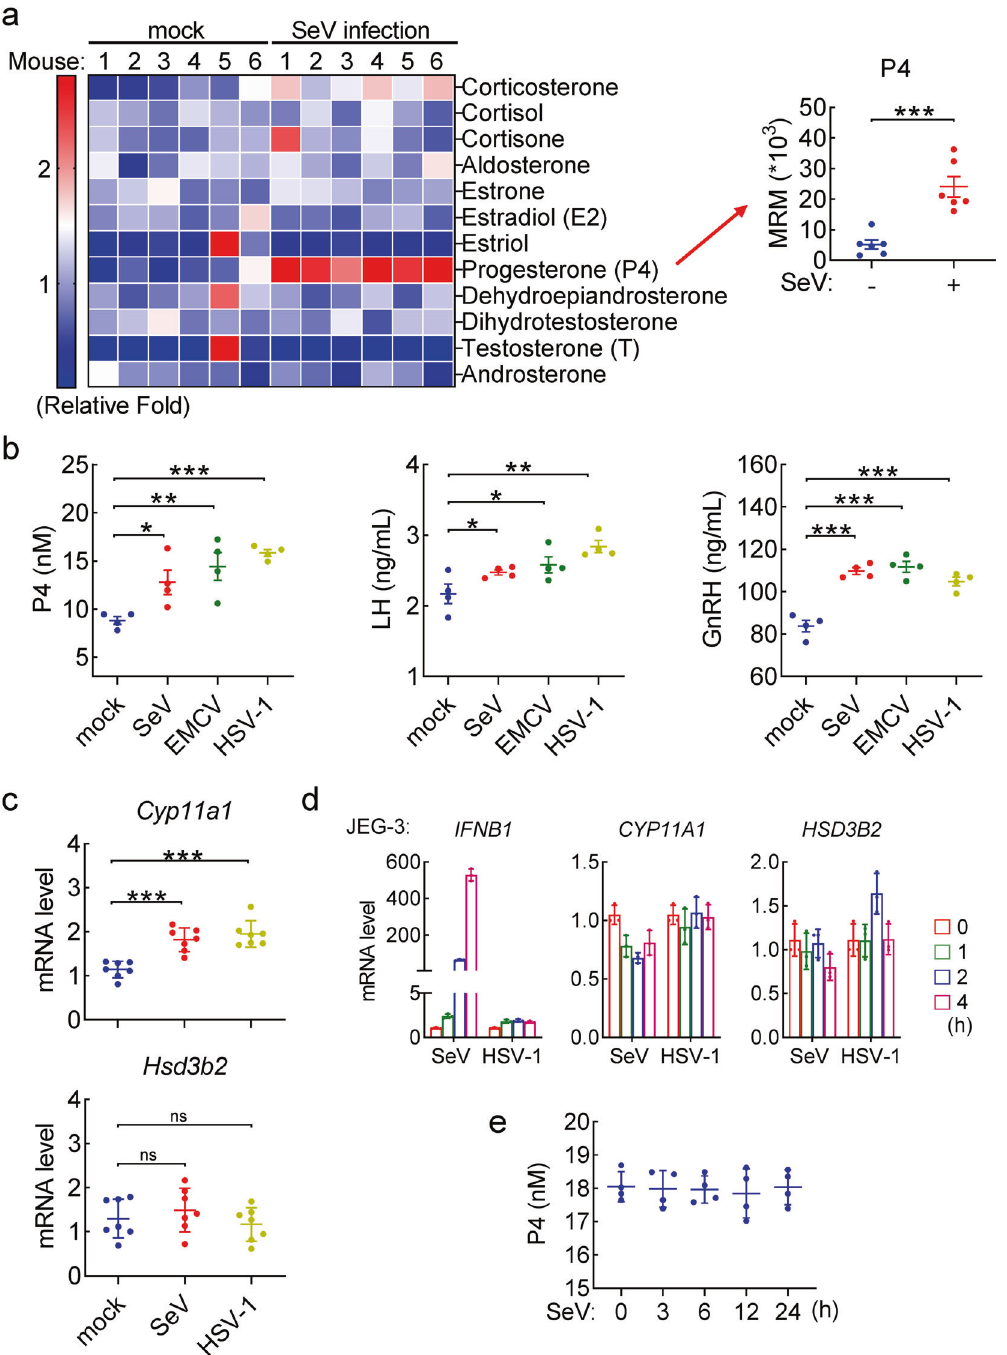
Fig. 1 Viral infection increases progesterone level in cells and mice. a Targeted metabolomic analysis of steroid hormones in sera of SeV- infected mice. C57BL/6 male mice ( n = 6 in each group) were left un-infected or infected intravenously with SeV for 3 h before the sera were collected and target metabolomic analysis was performed by liquid chromatography mass spectrometry (LC-MS). The data were then displayed by heatmap (the left panel), and the individual serum progesterone (P4) intensity in each sample was shown in the right histogram. MRM, multi reaction monitoring. b Measurement of neuroendocrine hormones in mice infected with different types of viruses. C57BL/6 male mice ( n = 4 in each group) were left uninfected or infected intravenously with SeV for 3 h, EMCV for 2 h or HSV-1 for 6 h before sera were collected for measurements of progesterone (P4), GnRH and LH as indicated by ELISA assays. c Measurement of the mRNA levels of Cyp11a1 and Hsd3b2 genes. C57BL/6 male mice ( n = 7 in each group) were left uninfected or infected intravenously with SeV for 3 h or HSV-1 for 6 h before their adrenal glands were collected for qPCR analysis of mRNA levels of Cyp11a1 and Hsd3b2 genes. d Measurement of the mRNA levels of CYP11A1 and HSD3B2 in human progesterone-producing cells. JEG-3 cells were left uninfected or infected with the indicated viruses for the indicated times before qPCR analysis of the mRNA levels of CYP11A1 and HSD3B2 genes. e . Effects of SeV infection on progesterone secretion in JEG-3 cells. JEG-3 cells were cultured in basic RPMI medium and then left uninfected or infected with SeV for the indicated times. The culture media were then collected for progesterone measurement by ELISA assays. * P < 0.05; ** P < 0.01; *** P < 0.001; ns not signi fi cant